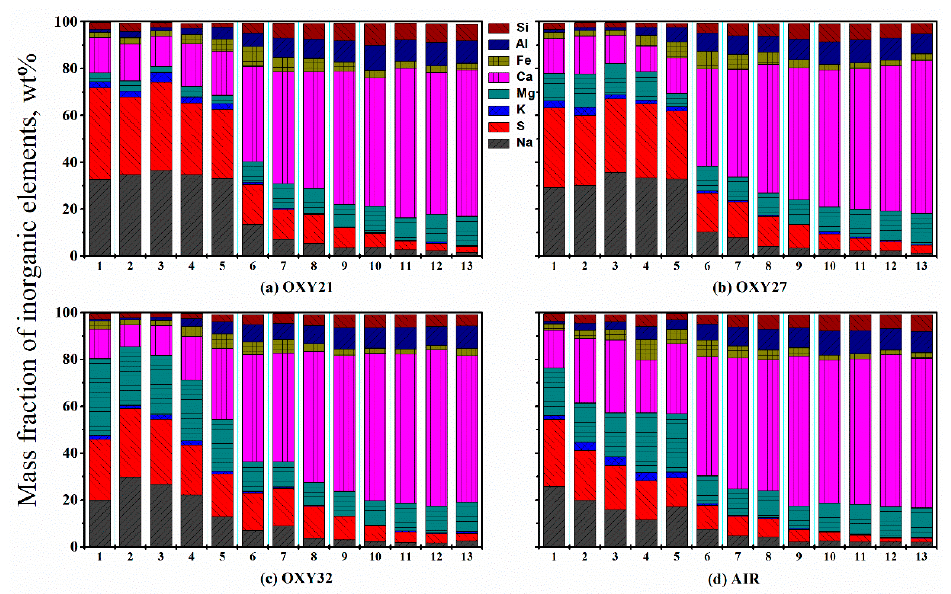
Figure 4. Inorganic elemental composition of PM10 formed during the air and oxy-fuel combustion of Zhundong coal. ( a ) OXY21; ( b ) OXY27; ( c ) OXY32; ( d ) AIR. Stages 1–13 have a D50 size of 0.039, 0.072, 0.122, 0.205, 0.32, 0.488, 0.765, 1.231, 1.951, 3.08, 5.144, 8.099 and 10.747 μ m, respectively. Particles less than 0.5 μ m in size (stages 1–5, called ultrafine particles and PM 0.5 ) present